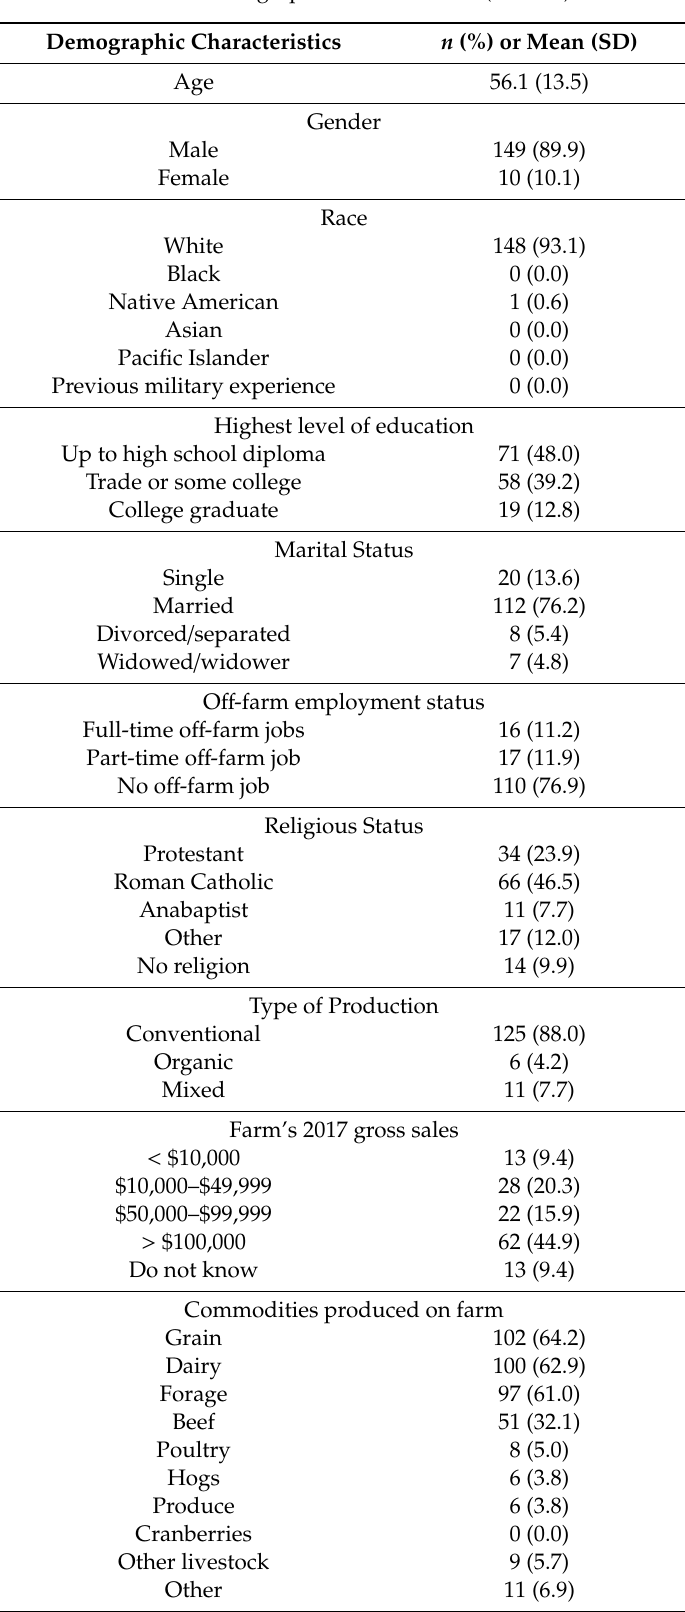
Table 1. Demographic characteristics ( n =